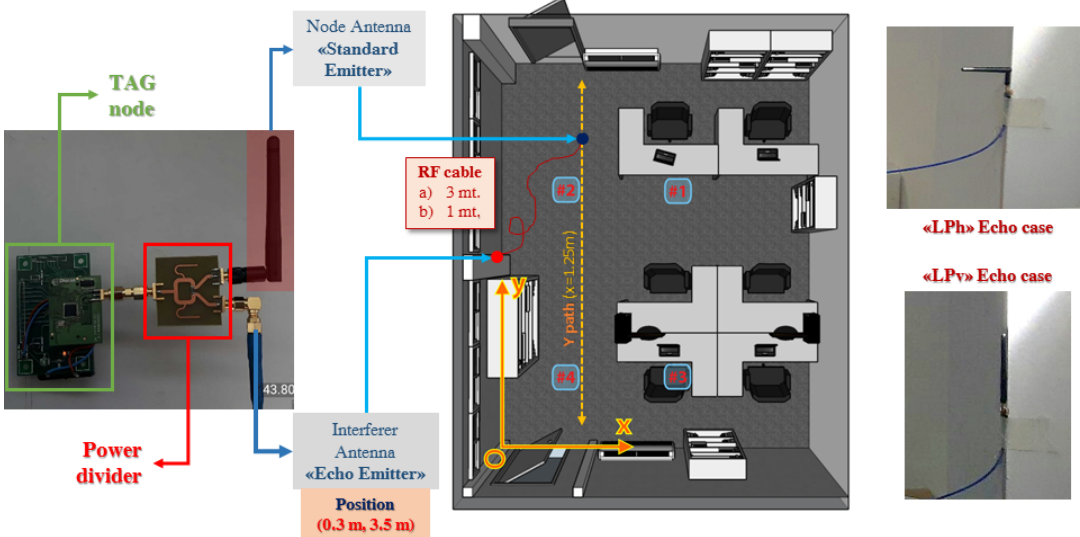
Figure 24. Strong Echo Interferer Experiment Configuration: Node structure ( Left ) experiment site ( Right